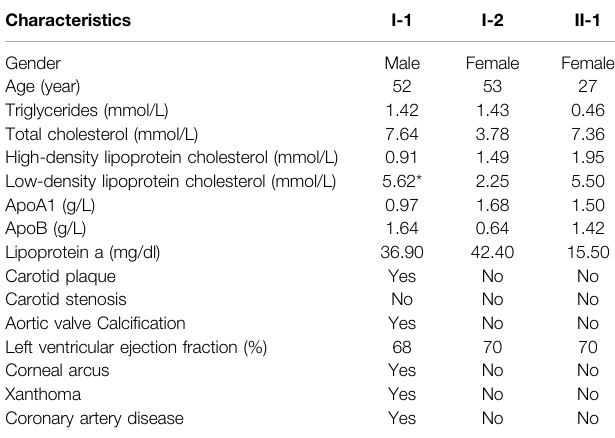
descending branch, 90% localized stenosis of the proximal TABLE 1 | Clinical data of FH patients and family members.